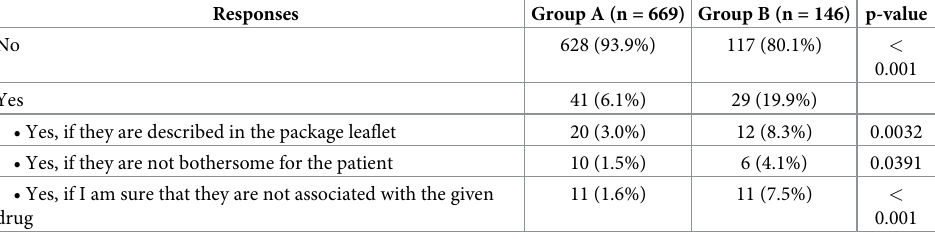
Table 4. Responses of Polish (group A) and American (group B) nurses to the question: “Did it happen in the pre- vious three years that you took no action when a patient reported worrying symptoms after the administration of any